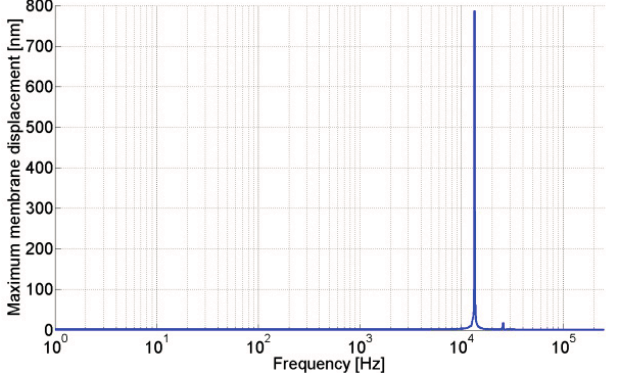
Figure 12. Maximum membrane displacement of the acoustic resonant sensor with set of optimum